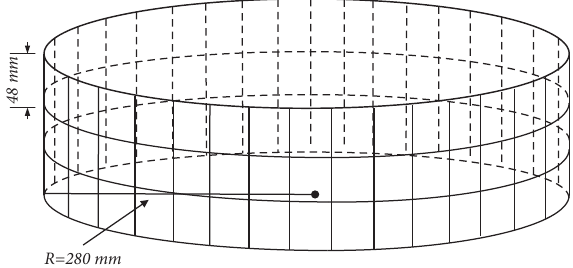
Figure 1: Cylindrical conformal array antenna consists of 3 layers, each layer containing 48